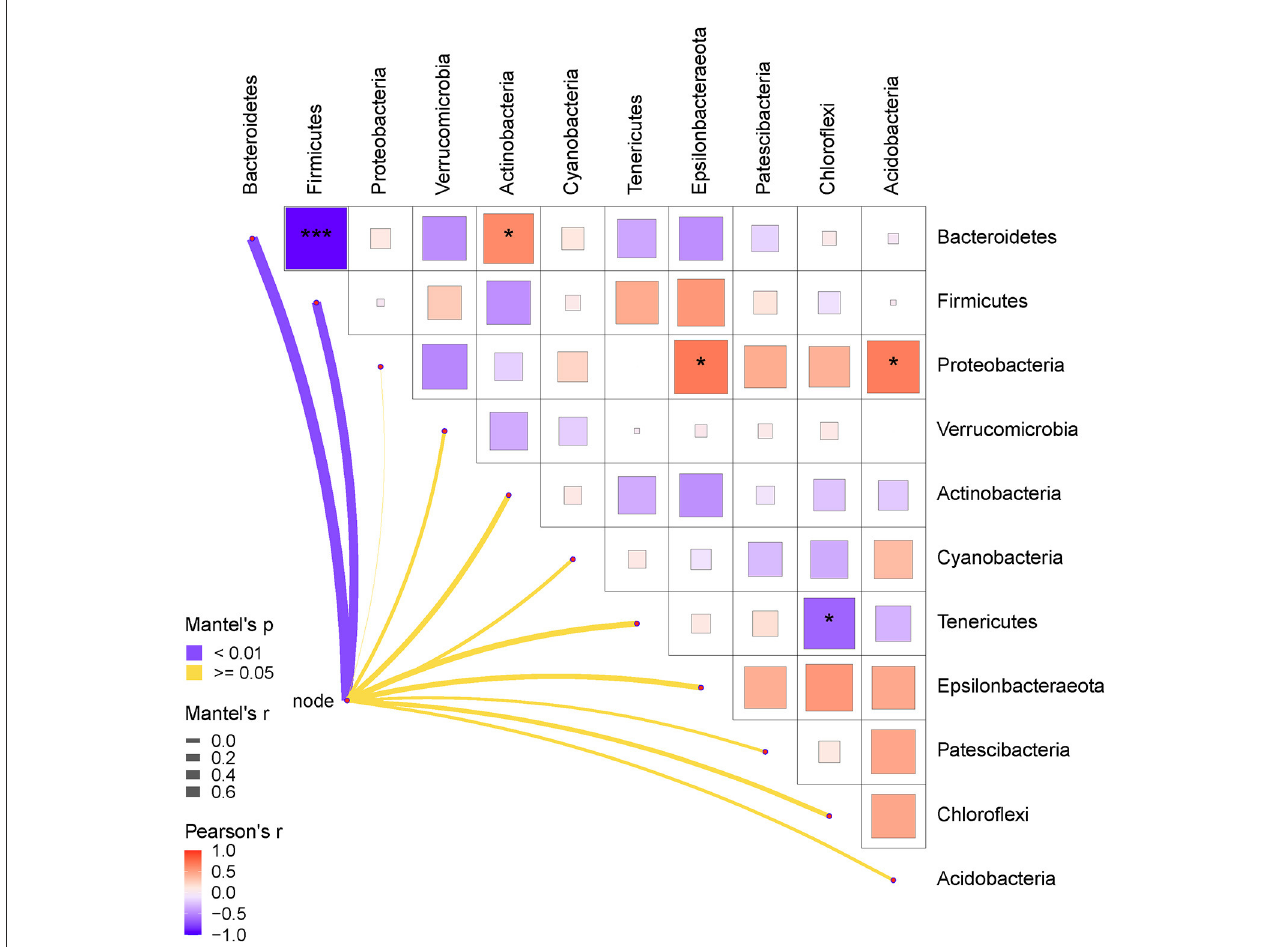
FIGURE5 Pearson correlation analysis of the RFI and the relative abundances of cecal bacteria (phyla level). The red color represents a positive correlation, while the blue color represents a negative correlation. The * symbol denotes a significant correlation (0.35 < |r| < 0.55, P < 0.05). The ** symbol denotes (0.55 < |r| < 0.75, P < 0.01). The *** symbol denotes (|r| > 0.75, P <